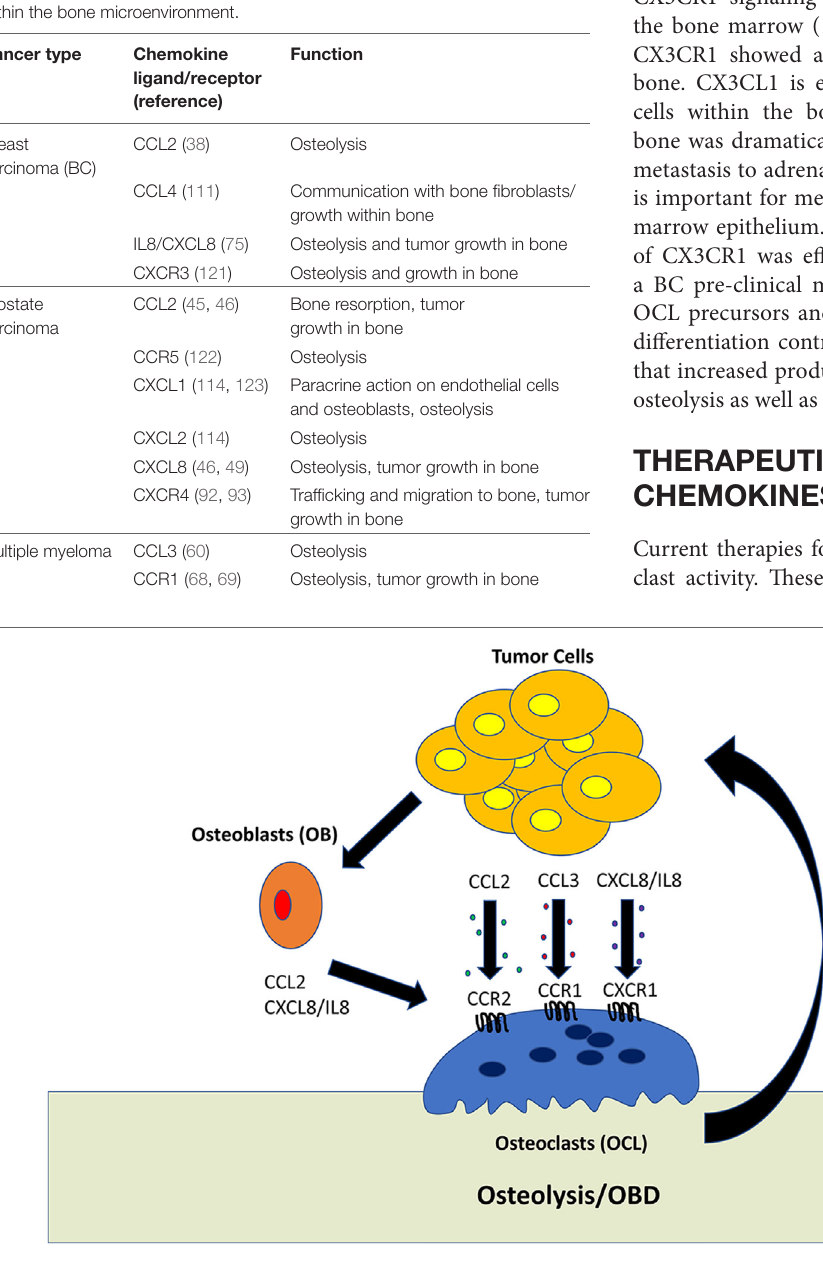
FigURe 1 | Role of tumor-derived chemokines in osteolysis. Osteoclasts (OCL) are multinucleated cells which mediate the resorption of bone. This process generally favors tumor growth within the bone microenvironment. Tumor cells can directly promote OCL activity by secreting the chemokines, such as CCL2, CCL3, and CXCL8/IL-8. In addition, tumor cells can stimulate osteoblasts to activate OCL differentiation and